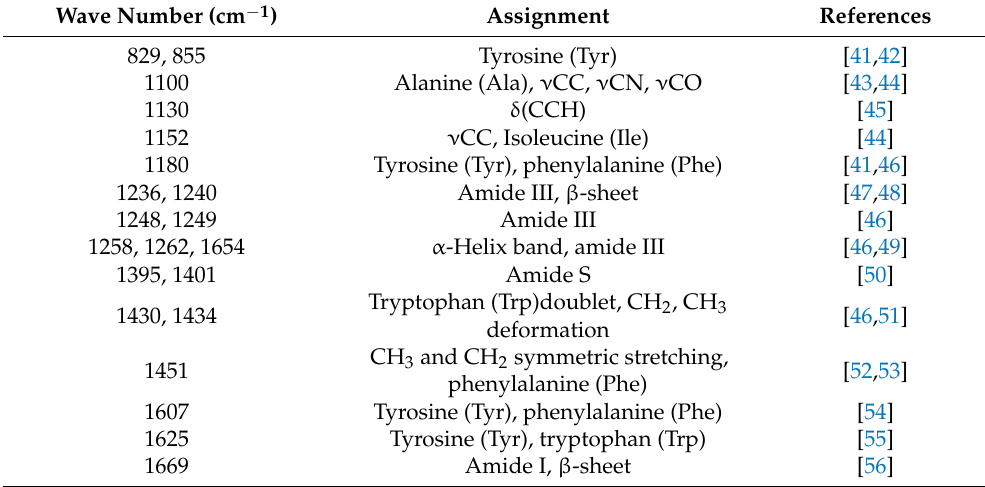
Table 1. Identifications of Raman and SERS